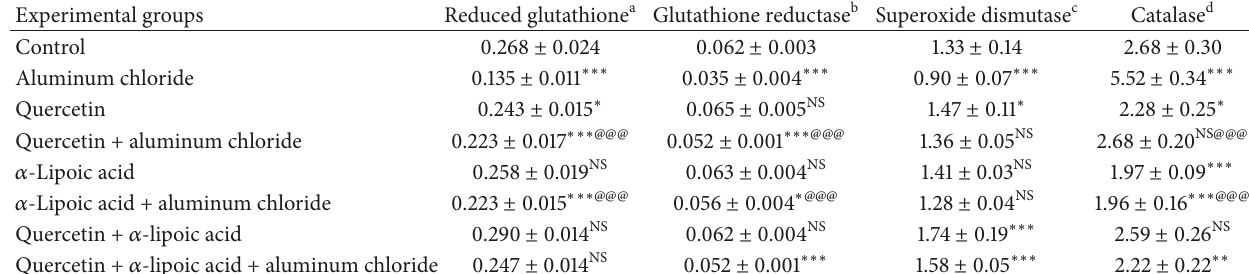
Table 2: Effect of aluminum chloride, quercetin, and 𝛼 -lipoic acid (ALA) treatment on various antioxidant defence indices in the brain of